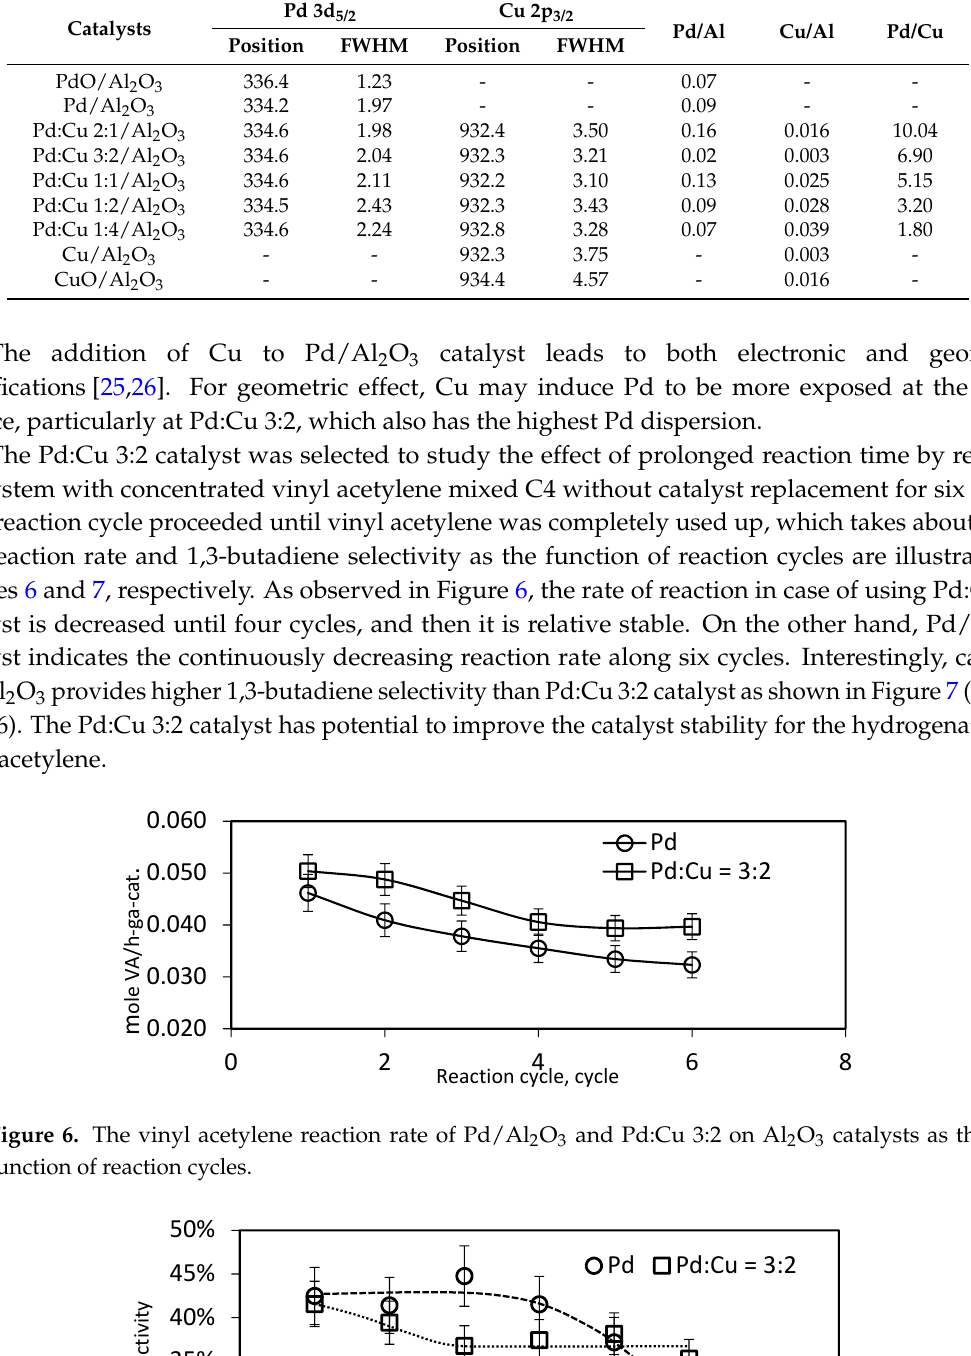
Table 2. The measured binding energy (eV), full width at half maximum (FWHM), and intensity ratios of Pd, Cu, and Pd-Cu on Al 2 O 3 .